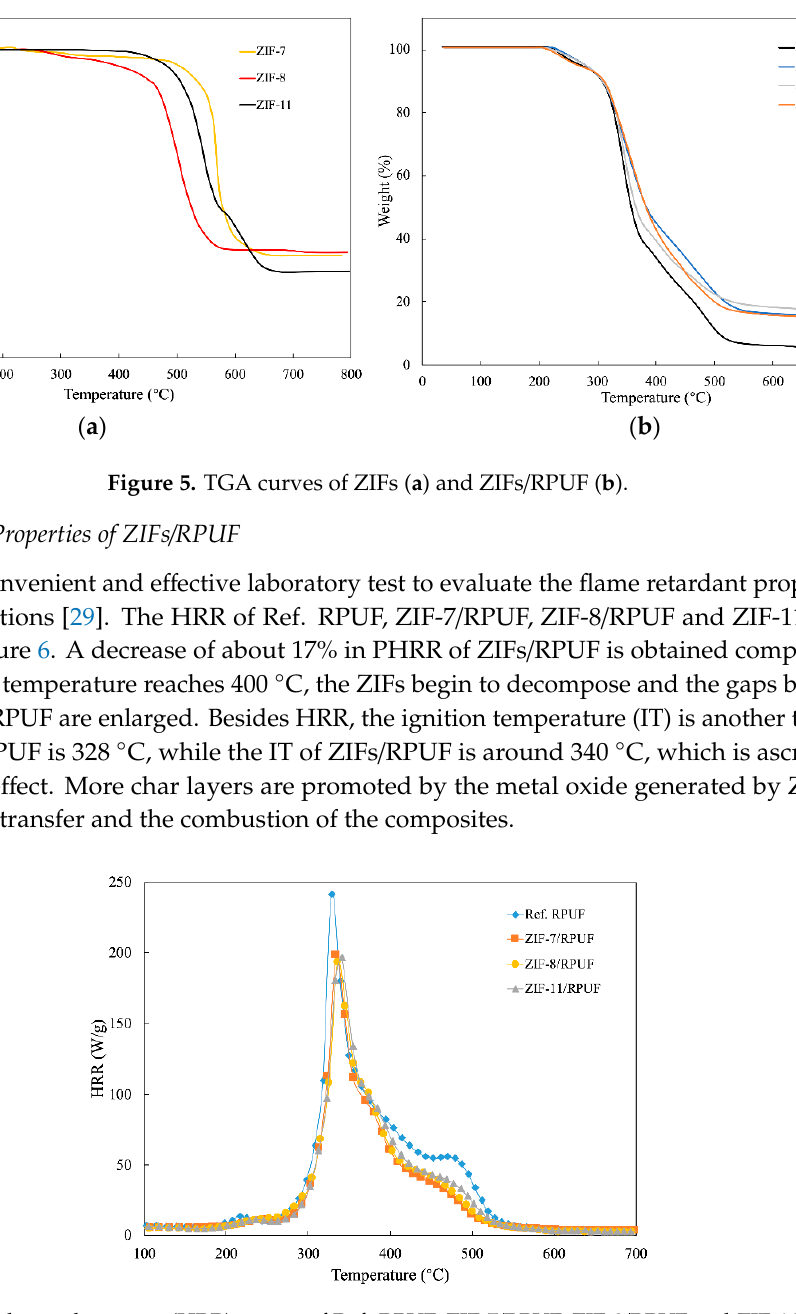
Figure 6. The heat release rate (HRR) curves of Ref. RPUF, ZIF-7/RPUF, ZIF-8/RPUF and ZIF-11/RPUF.